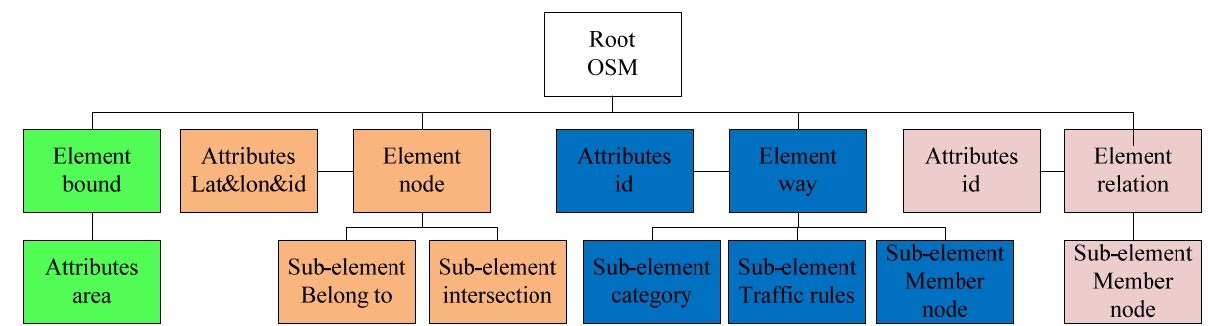
Figure 3. Treelike structure of OpenStreetMap data.